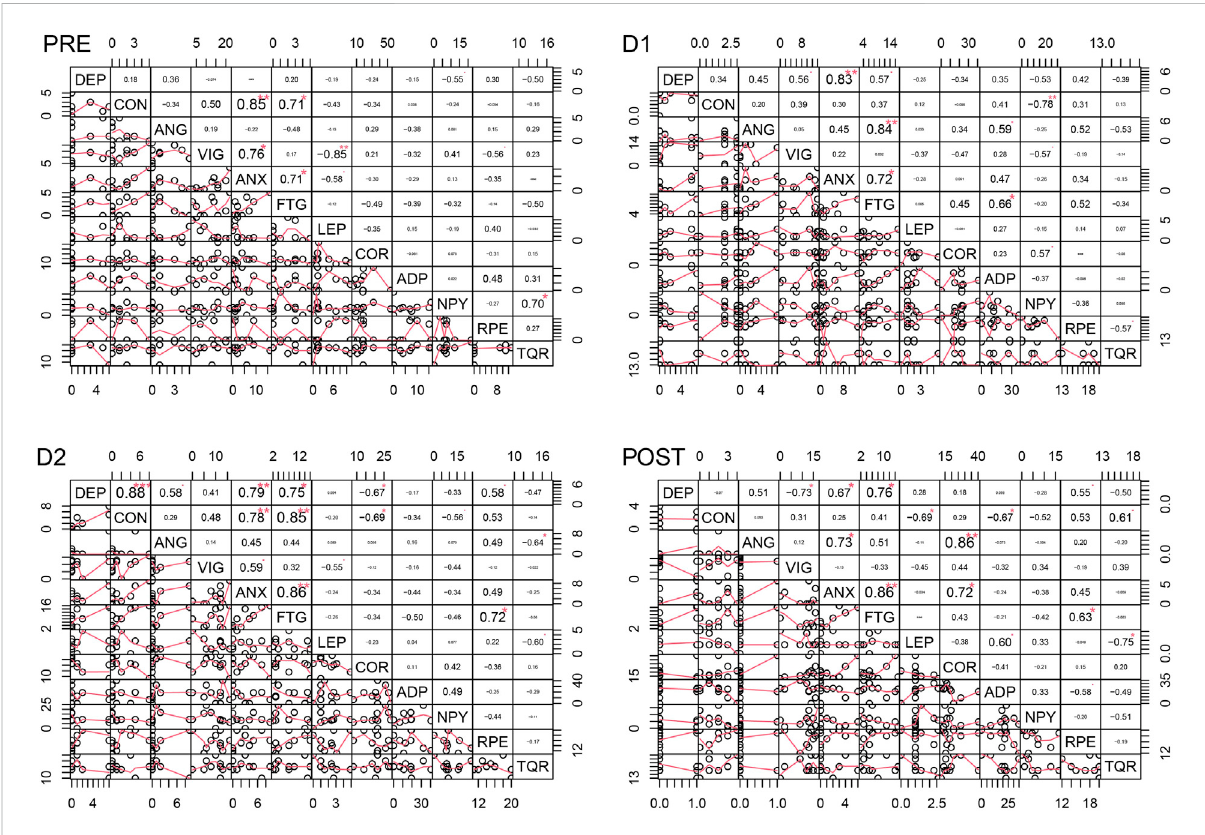
FIGURE 5 Correlationanalysesforthe fi nishergroupatfourtimepoints.DEP=Depression,CON=Confusion,ANG=Anger,VIG=Vigor,ANX=Tension- ANXiety, FTG = Fatigue, LEP = Leptin, COR = Cortisol, ADP = Adiponectin, NPY = Neuropeptide Y, RPE = Ratings of Perceived Exertion, TQR = Total Quality of